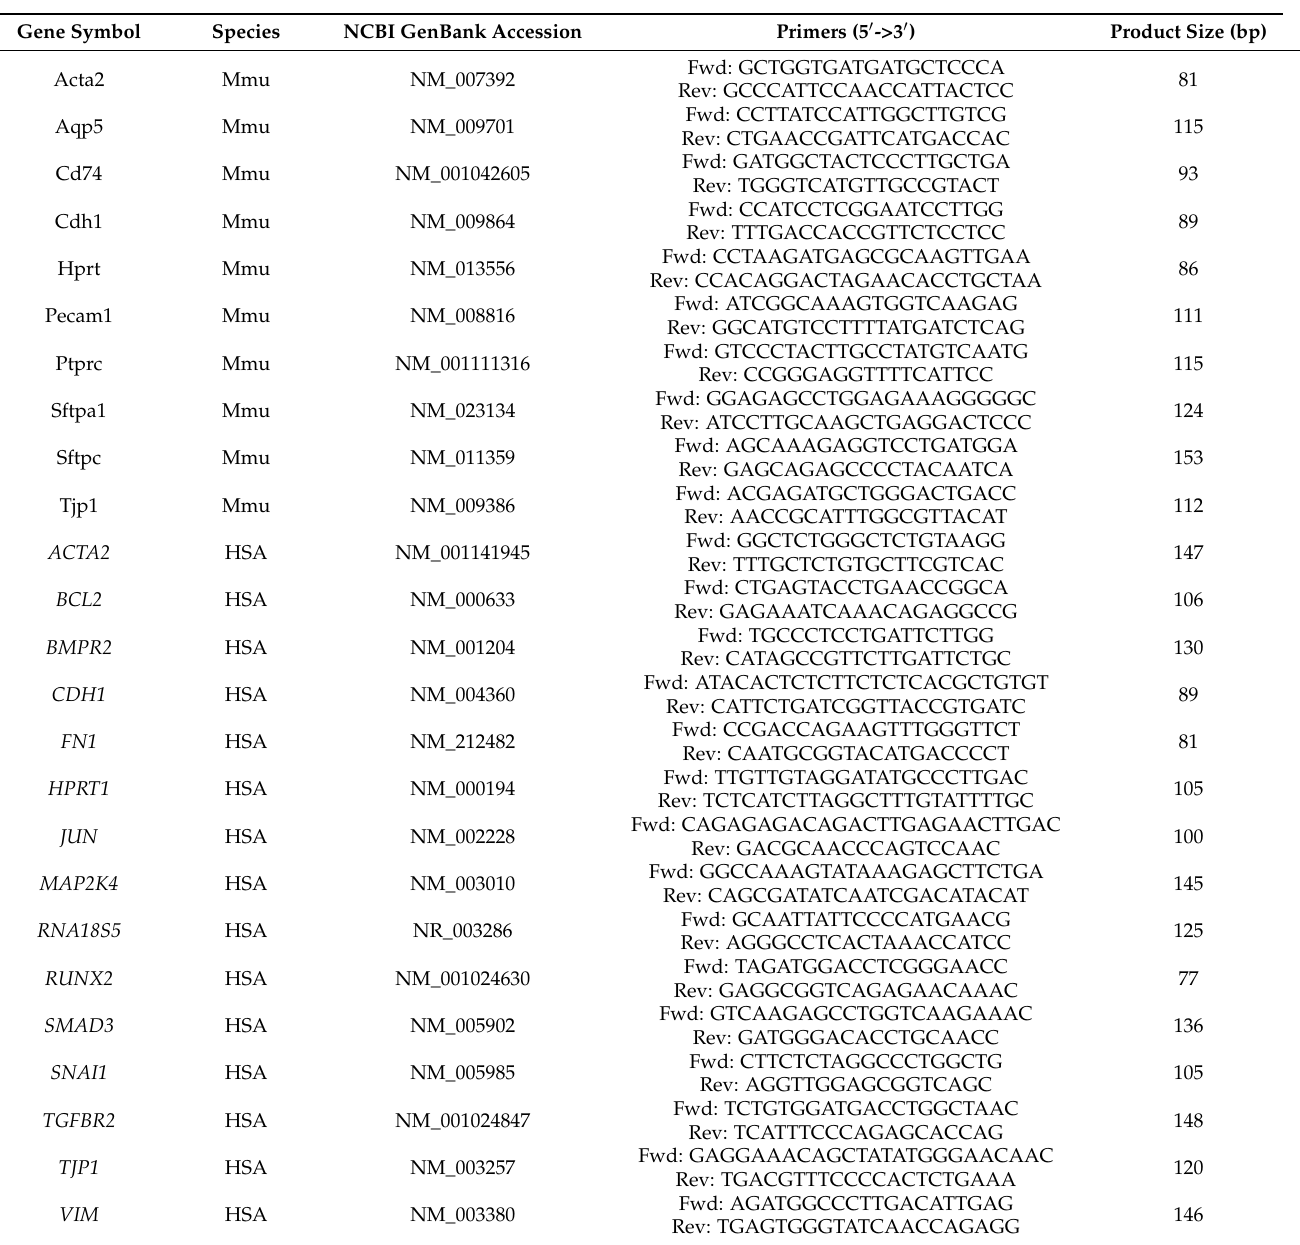
Table 2. Primers used for